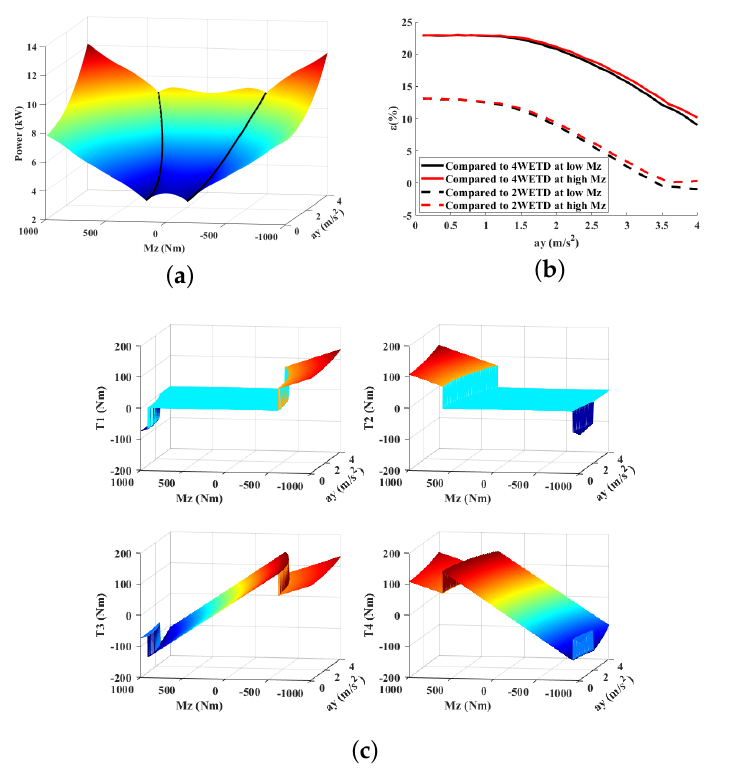
Figure 5. Results versus M z for constant velocity cornering with Motor II: ( a ) Minimal power; ( b ) Percentage of energy saving; ( c ) Optimal wheel torques.